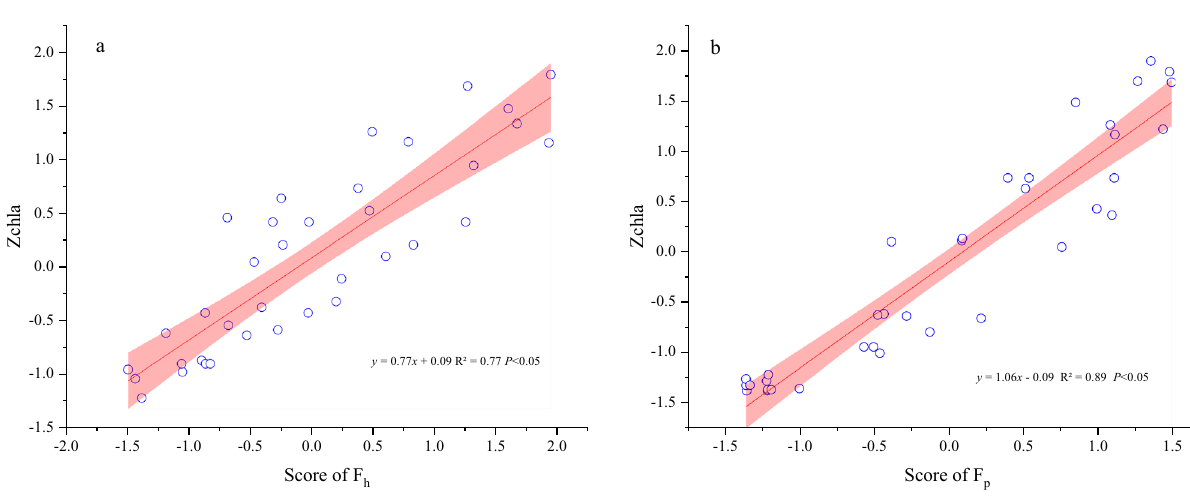
Figure 4. The relationship between Z score of Chl a and score of F h and F p